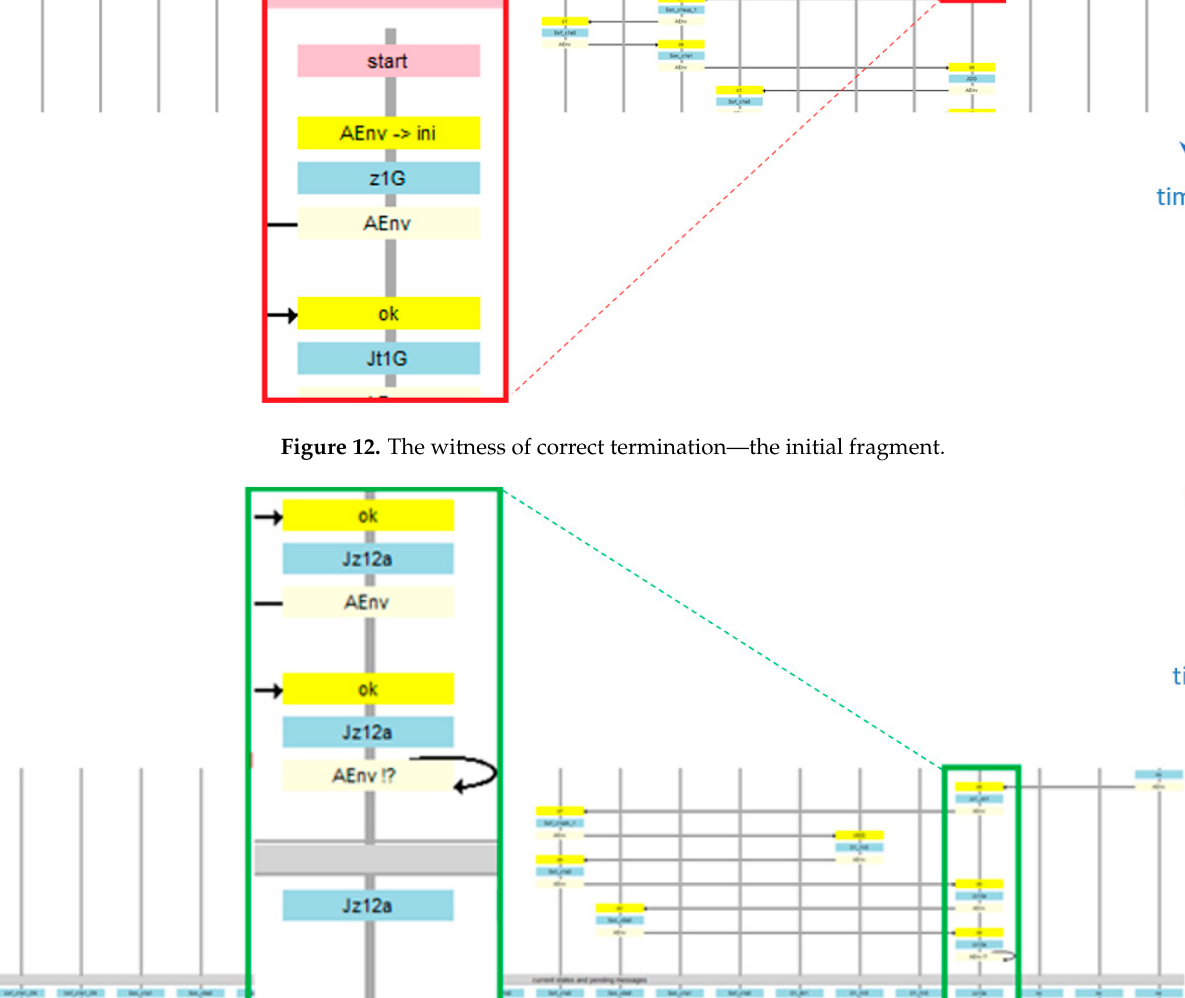
Figure 13. The witness of correct termination—the final fragment.